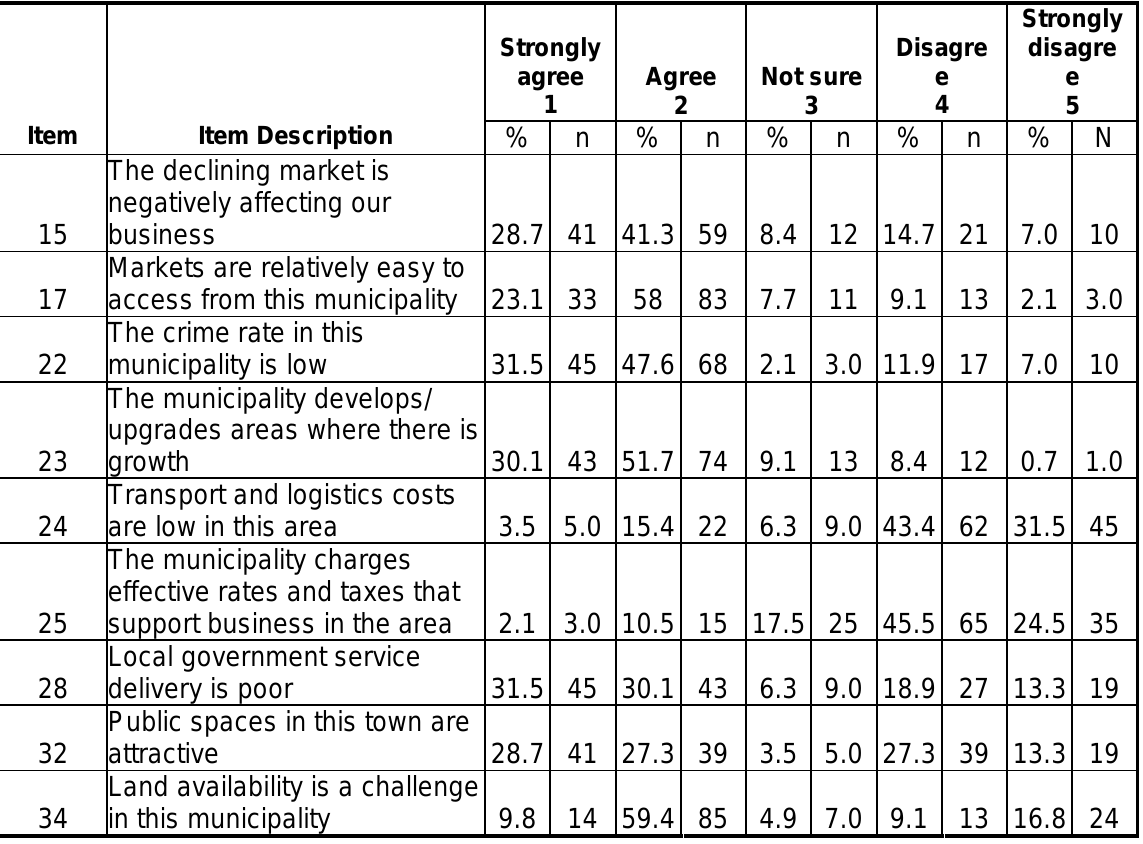
Table 8: Responses to items in the Local Environment factor Item Item